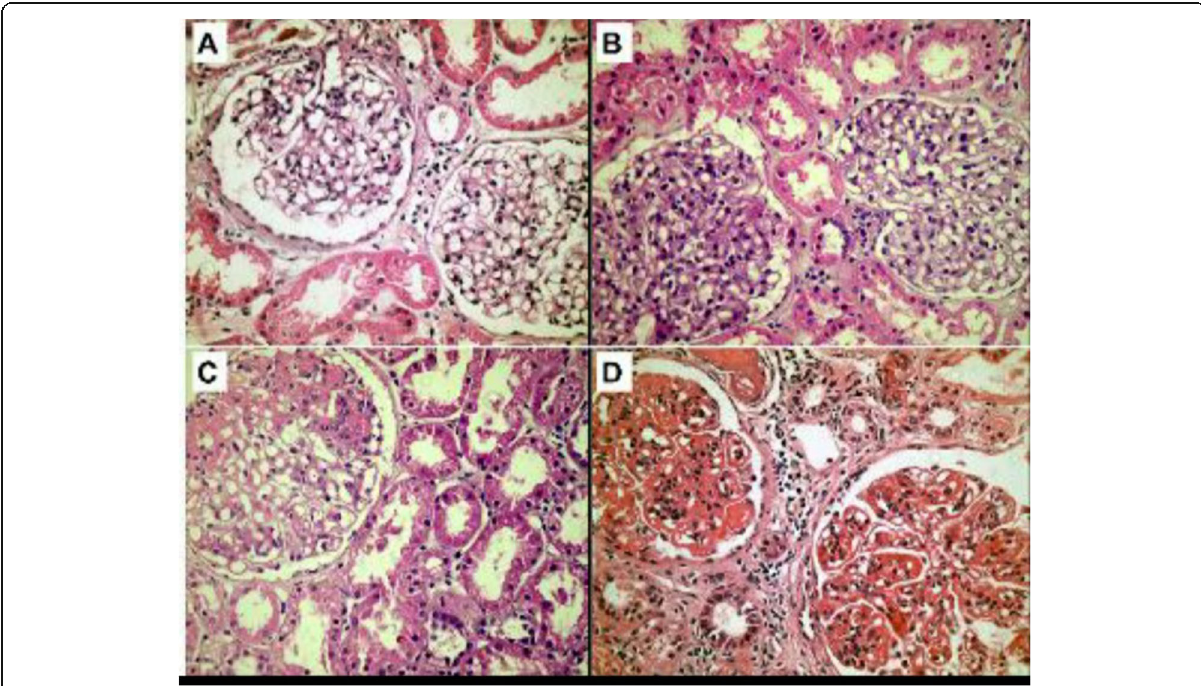
Fig. 1 Different stages of LN in investigated cases including a mesangial proliferative LN (stage II), b focal active/chronic LN (stage III A/C), c